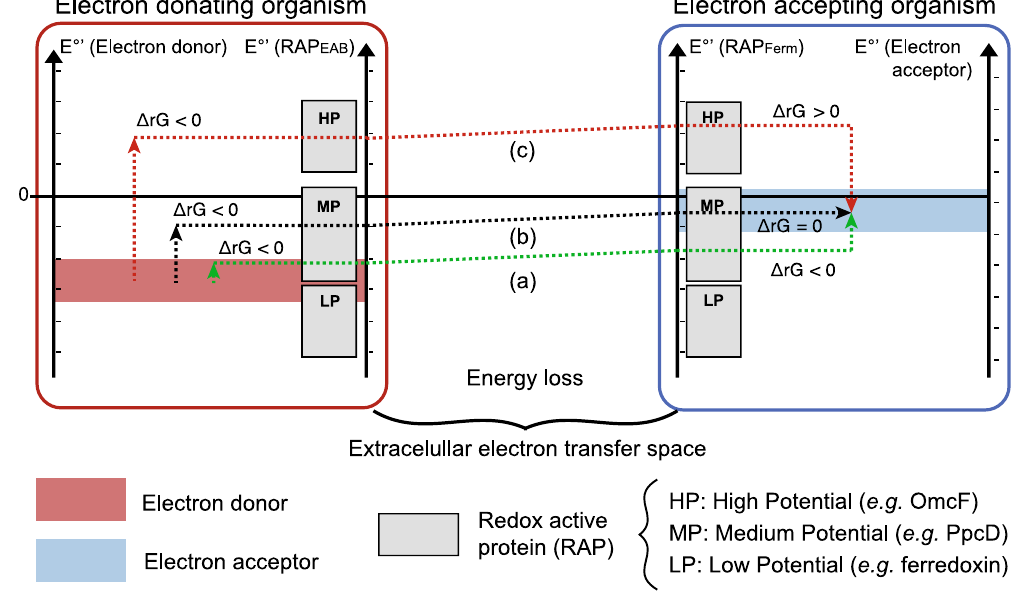
Figure 1. Energetic partitioning during IET: ( a ) Energetic mutualism; ( b ) Energetic commensalism; ( c ) Energetic parasitism. The ranges for redox active proteins were represented according to Santos et al . 22